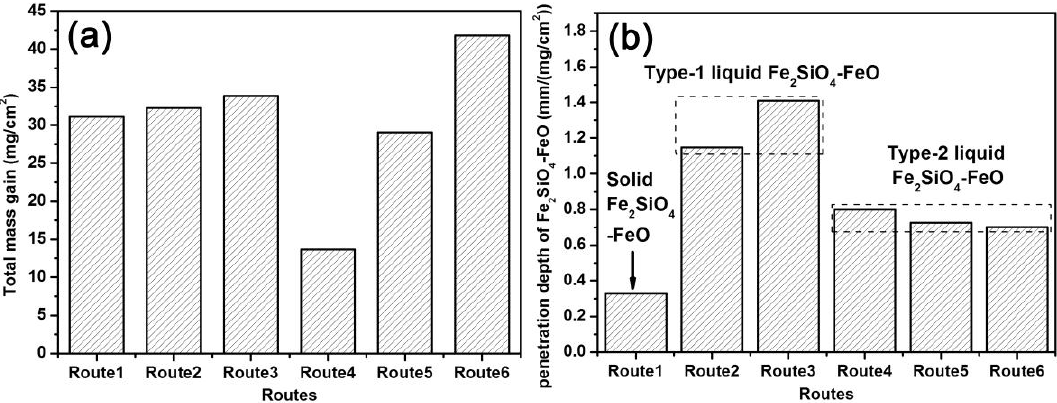
Figure 6. ( a ) The total mass gain for Routes 1–6. ( b ) The normalized penetration depth of Fe 2 SiO 4